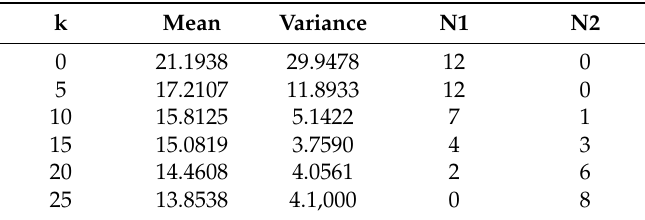
Figure 12. Angle and range fluctuations of the commencement of B1-cylinder exhaust valve closing impact in 480 combustion cycles with different values of k. Table 4. Statistics of the commencement of B1-cylinder exhaust valve closing impact in 480 combustion cycles calculated with different values of k; N1 and N2 represent the number of outliers that are more than three times the standard deviation of plus and minus, respectively.